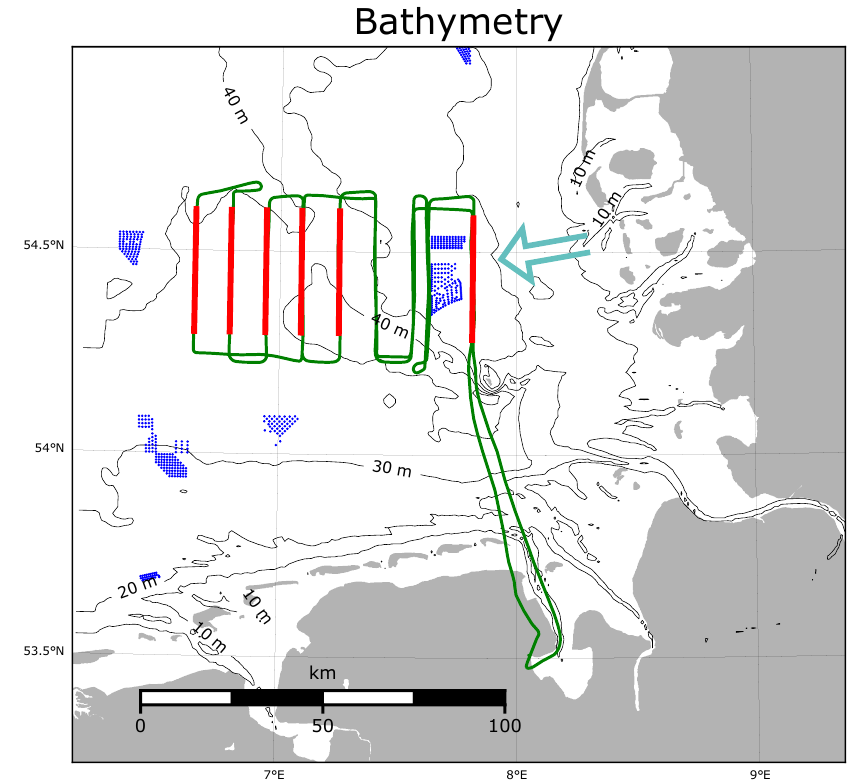
Figure 3. Map of the German Bight of the North Sea. Land areas are indicated in gray. The lines show bathymetry with 10, 20, 30, and 40m isobaths. Wind turbines in operation in August 2017 are each shown as blue asterisks. The flight pattern is given as a green line, and the horizontal flight legs used in the laser scanner analyses are indicated as red lines. The arrow in light blue indicates the wind